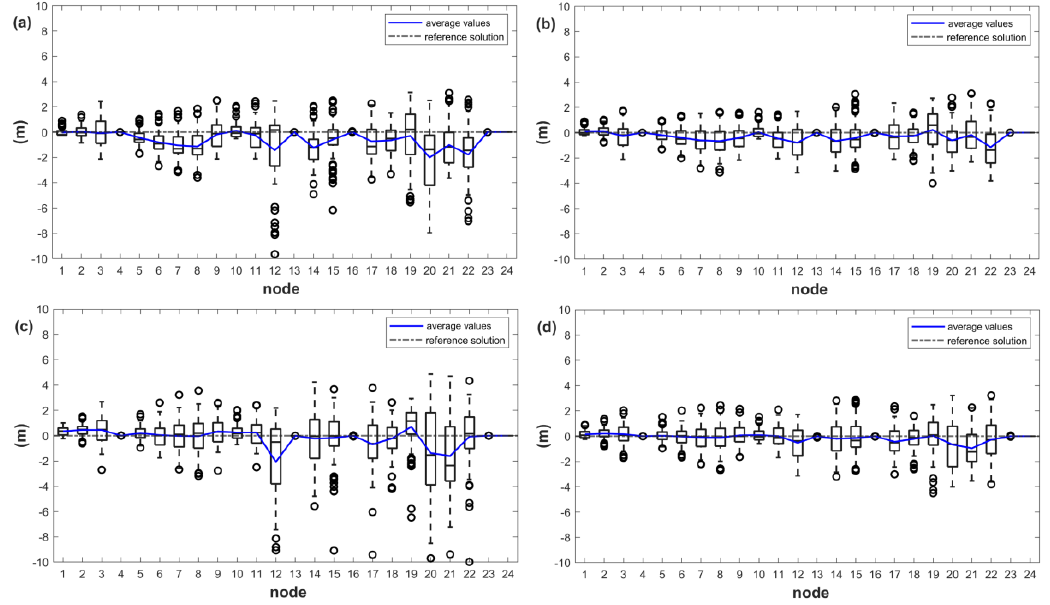
Figure 4. Pressure errors (i.e., the difference between simulated and reference values) at each node of the 100 runs for each hydraulic approach: ( a ) NDD; ( b ) NPD; ( c ) DDD; ( d ) DPD. The error of the average values (i.e., average values line) is also displayed in each plot.